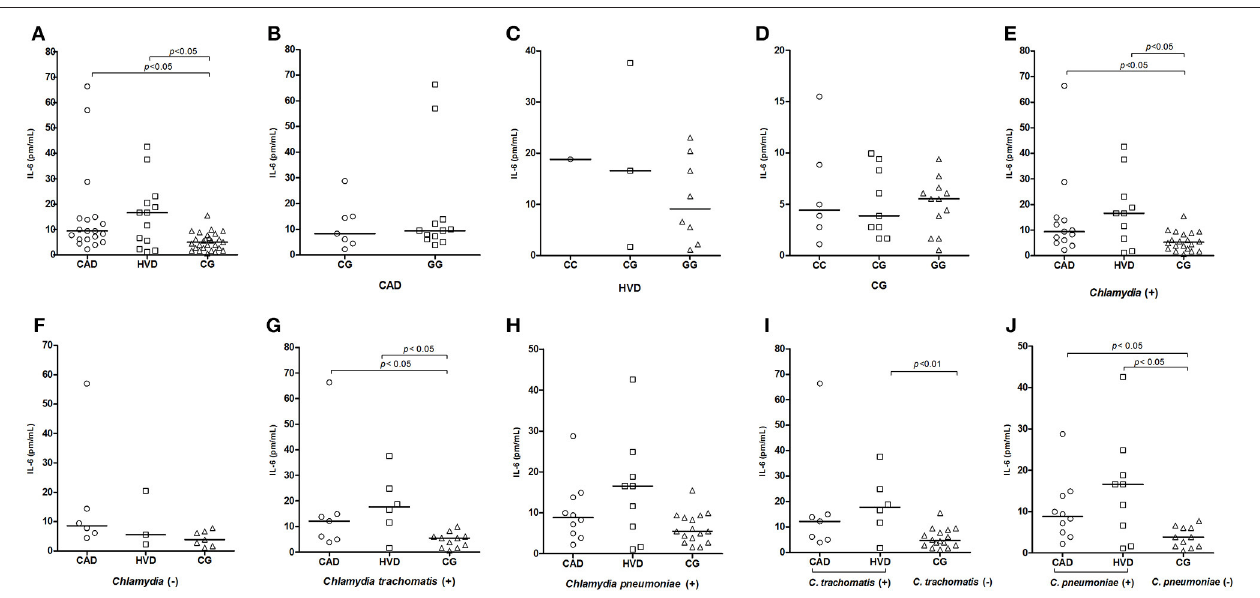
FIGURE 2 | Distribution of plasma IL-6 levels (A) among patients receiving surgical revascularization for coronary artery disease (CAD), patients undergoing valve replacement for heart valve disease (HVD) and control subjects (CG); (B–D) according to the different IL-6 -174G > C genotypes; (E) among groups serologically positive and (F) negative for Chlamydia ; (G,I) among groups with and without previous exposure to C. trachomatis and (H,J) to C. pneumoniae